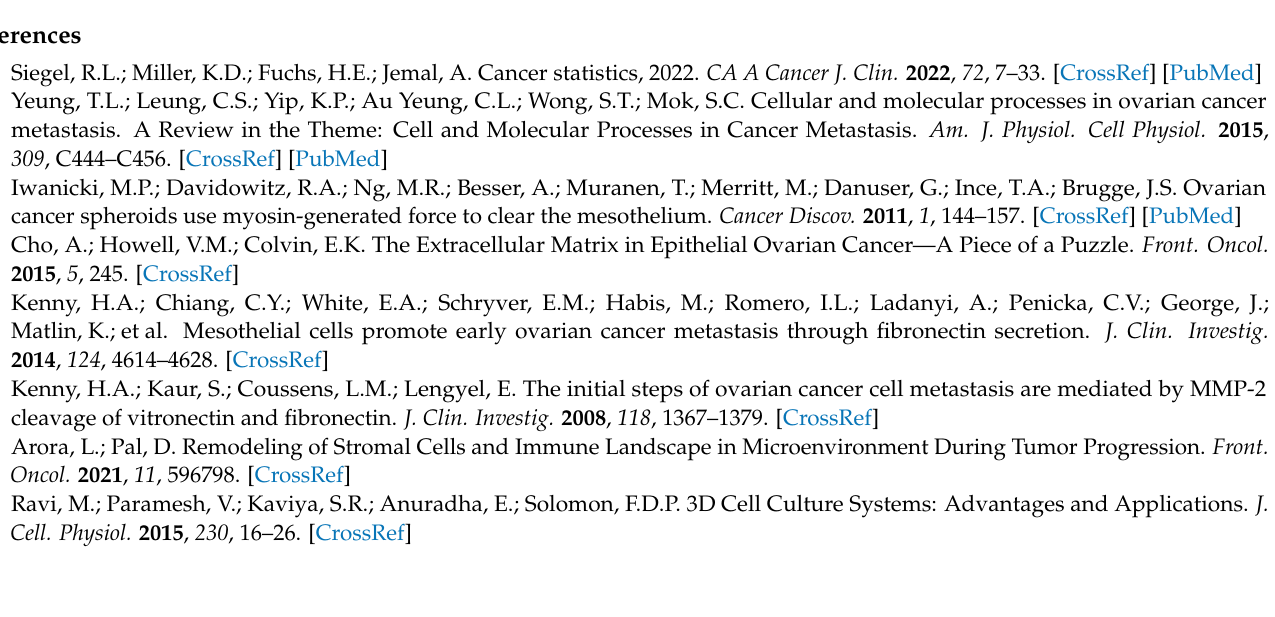
tumor cells. Figure S2D: DDR2 does not regulate periostin expression in ovarian cancer cell lines. Figure S3A: DDR2 depletion in CAFs leads to marginal differences in tumor cell attachment in the presence of HPMCs. Figure S3B: Matrigel transwell tumor invasion assay with COV362 cells using conditioned media from DDR2 knockdown and POSTN overexpression CAFs. Figure S4: DDR2’s regulation of periostin increases tumor spreading. Figure S5: Regulatory network including DDR2, periostin and ITGB1. Figure S6: Immunohistochemistry for (A) Stromal POSTN positive and (B) Stromal DDR2 positive cores. 5 ×